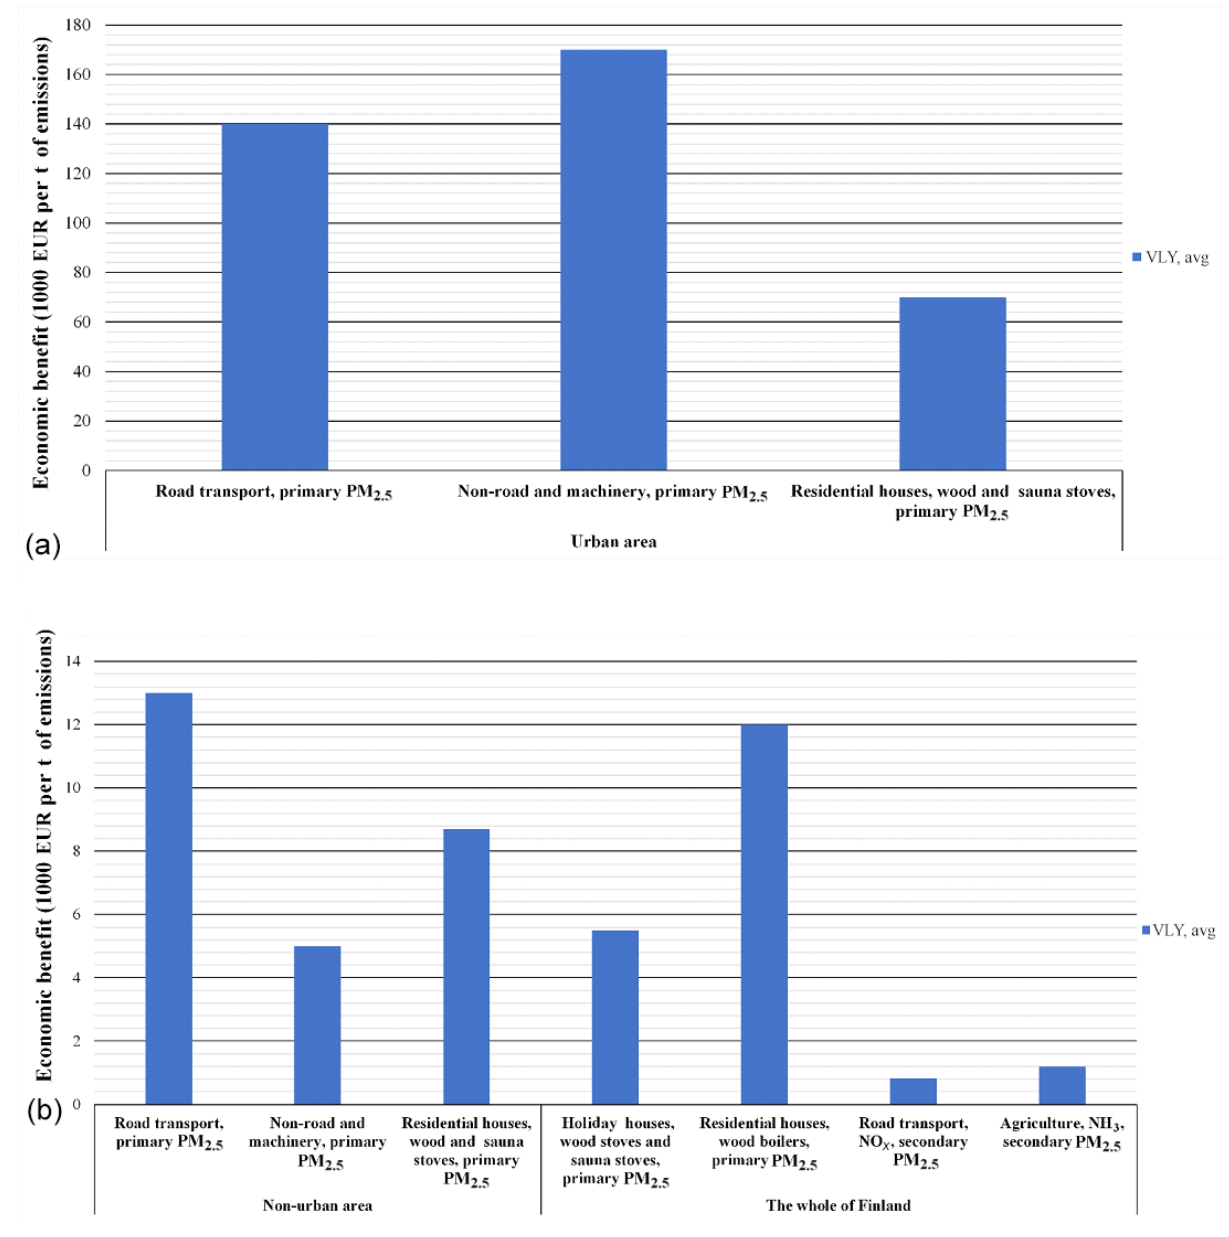
Figure 5. Economic benefits obtained from the assumed reductions in emissions, in 1000 EUR per tonne of emissions, for sources having a low emission height. The results are presented for urban areas (a) and for non-urban areas and for the whole country (b) in the cases of various source categories and pollutants in various domains. All the values correspond to the computations using the average value of life year